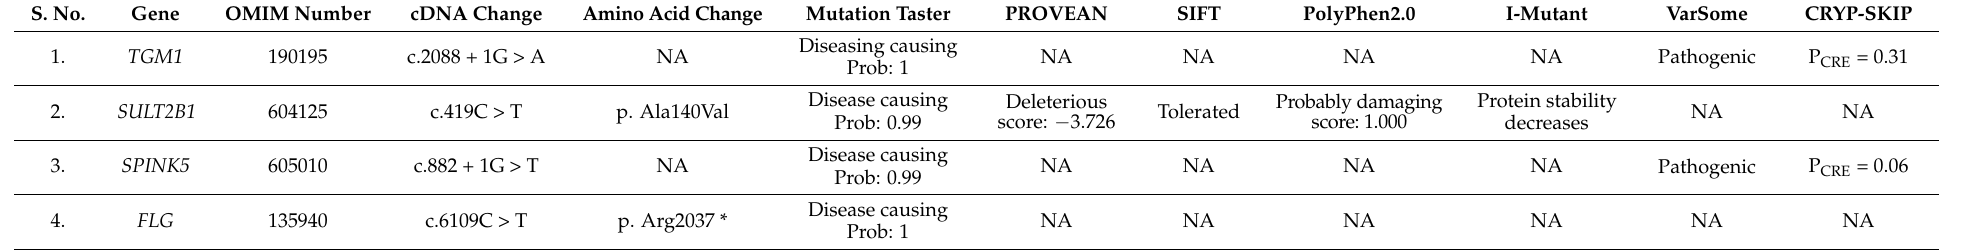
Table 2. Bioinformatics analysis of the identified sequence variants in four Pakistani ichthyosis